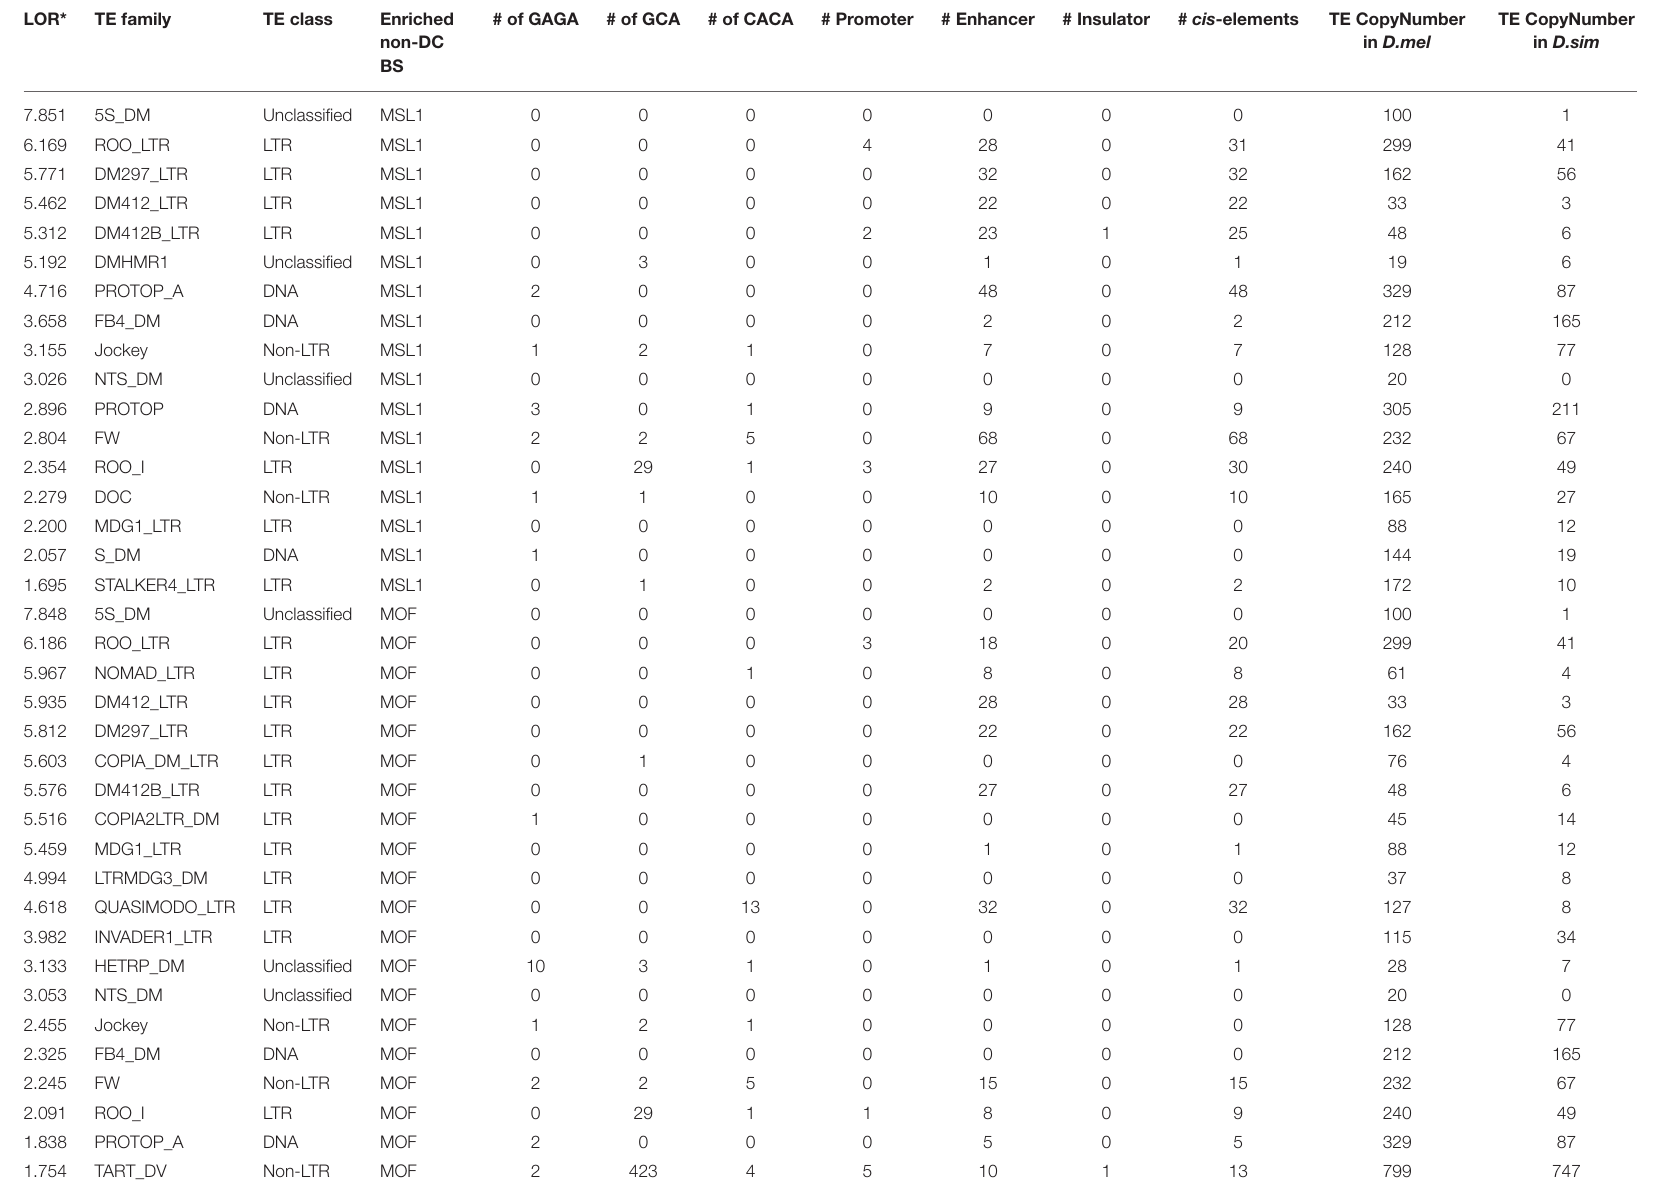
TABLE 3 | Summary of motifs and cis -regulatory elements specific TE family consensus sequences enriched in non-DC binding sites in D. melanogaster